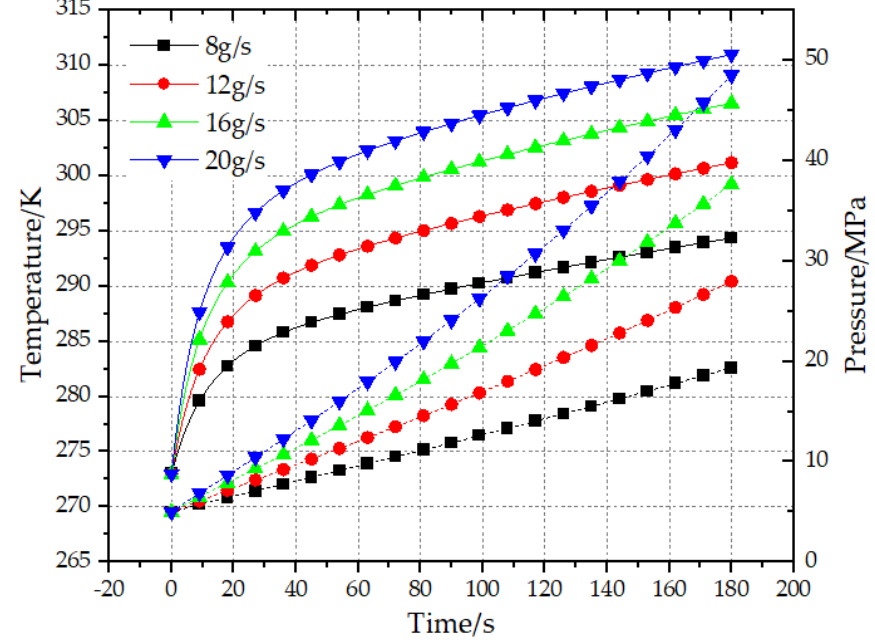
Figure 10. Effect of mass flow rate on the temperature and pressure revolution.